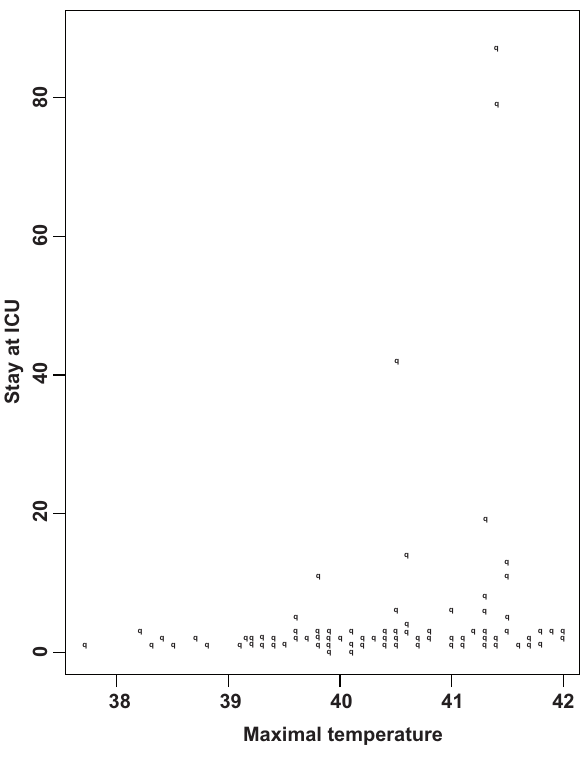
Figure 7. Stay at ICU (days) versus maximal temperature ( ° C). Scatterplot showing the relation between stay at ICU and Tmax.